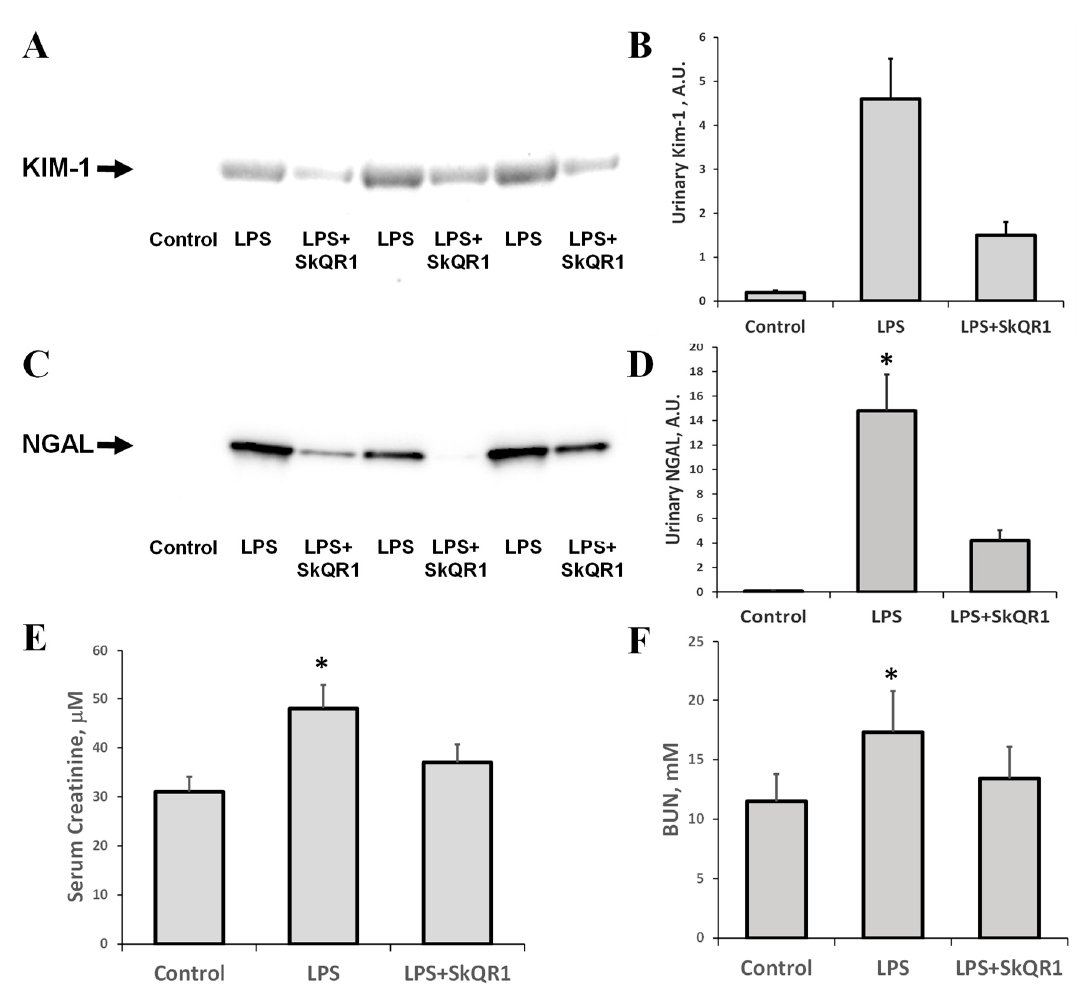
Figure 4. Acute kidney injury (AKI) in neonatal rats 24 h after LPS administration and e ff ect of SkQR1. A significant increase (*, p < 0.05) in urinary kidney injury molecule (Kim-1, A ) and neutrophil gelatinase-associated lipocalin 1 (NGAL, C ) content were observed, indicating the development of severe AKI. The diagrams in ( B , D ) represent densitometry analysis of corresponding bands on the blots. The number of animals for western blot densitometry was n = 3 for all groups. SkQR1 treatment protected the kidney from AKI, in terms of KIM-1 and NGAL levels in urine. Renal function was measured as the concentration of creatinine ( E ) and blood urea nitrogen (BUN) ( F ) in blood. A significant (*, p < 0.05) increase in serum creatinine and BUN was found after LPS administration; however, SkQR1 treatment restored the levels of these markers.